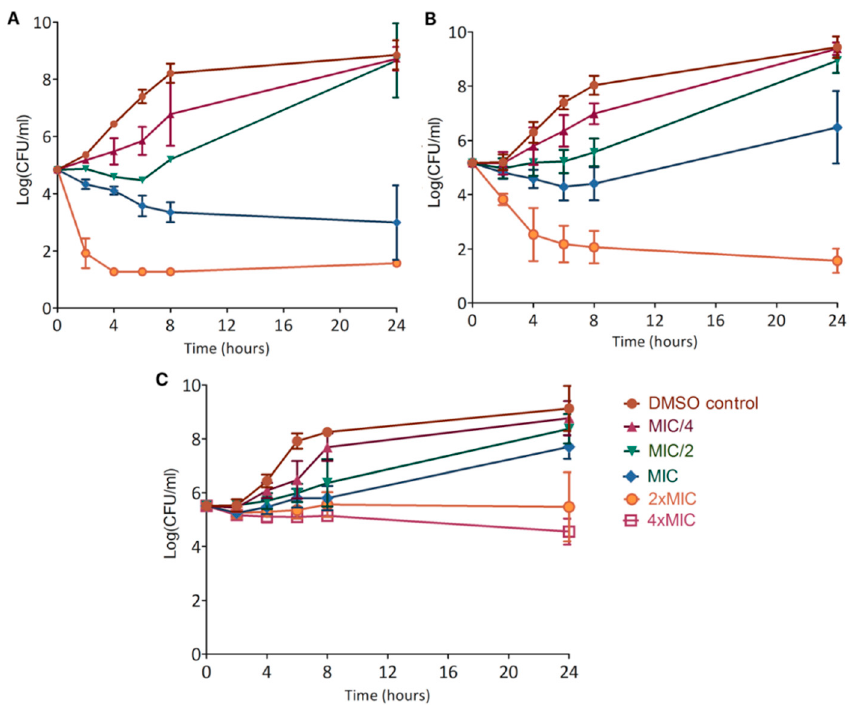
Figure 5. Kill curves showing the effect of xanthohumol ( A ), desmethylxanthohumol ( B ) and lupulone ( C ) on S. aureus T28.1 growing during 24 h. The detection threshold of the experiment is 1 log(CFU/mL).